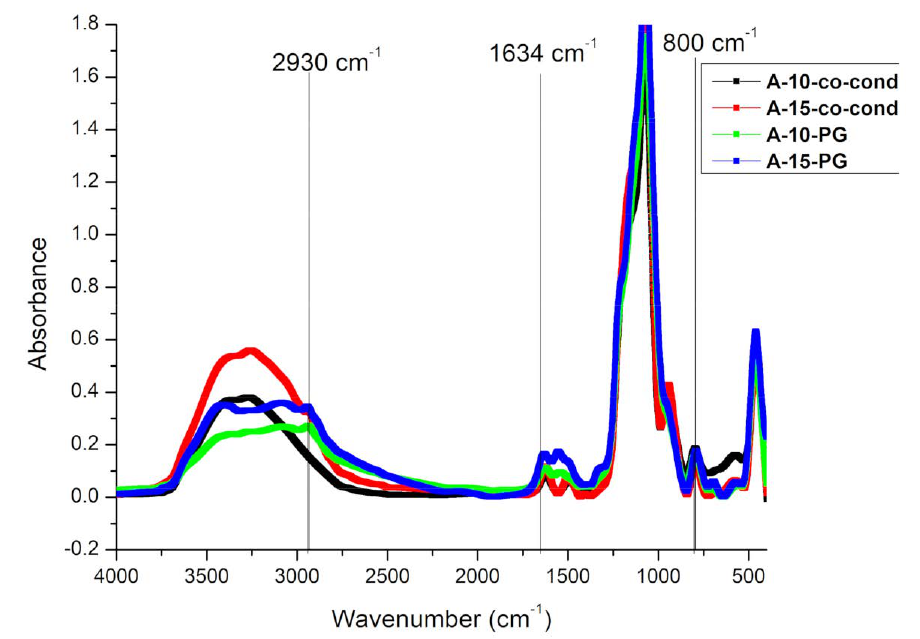
Figure 1. The FT-IR spectra of the functionalized